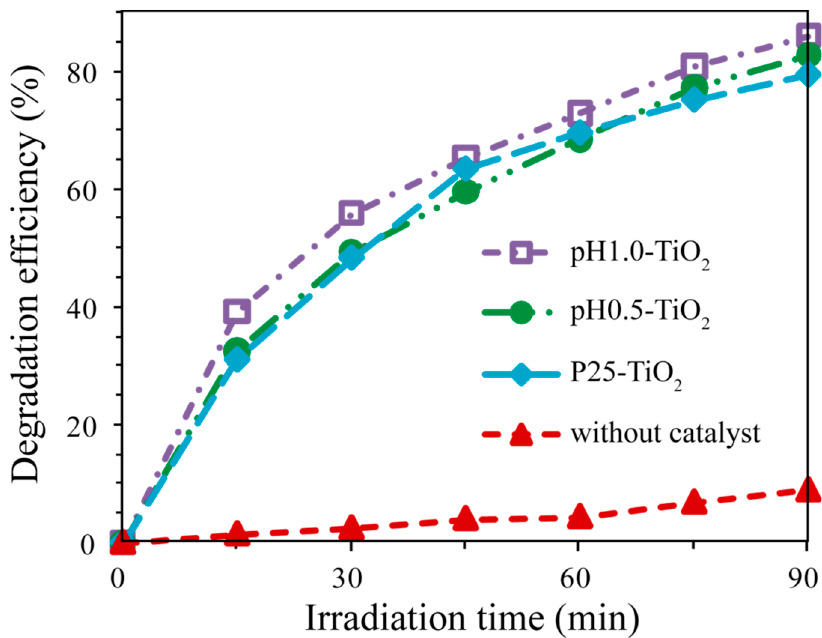
Figure 6. Time-dependent photodegradation profiles of MB over pH0.5-TiO 2 , pH1.0-TiO 2 , and P25-TiO 2 photocatalysts, and a blank sample without any catalysts under UV irradiation.